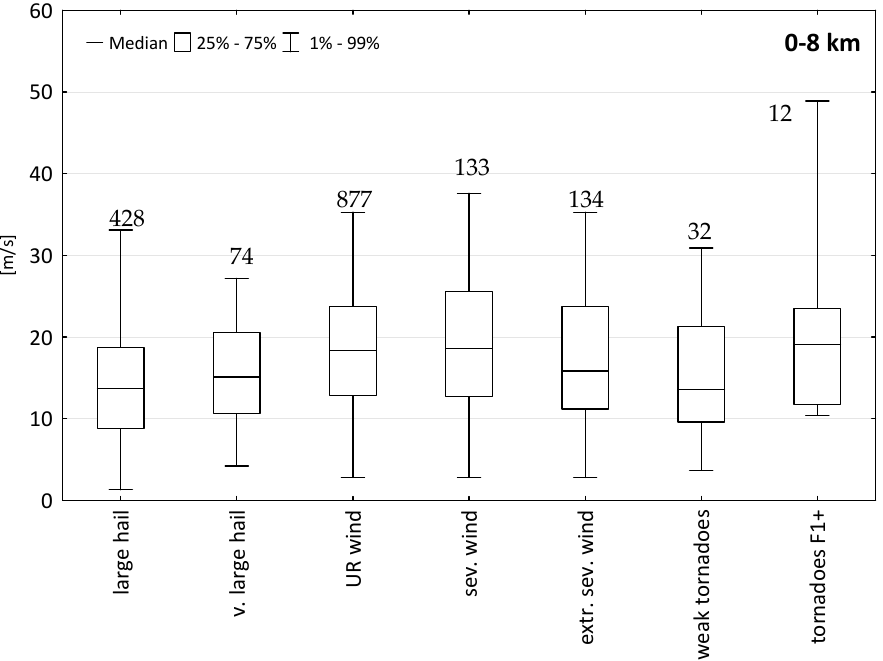
Figure 6. As in Figure 2, except for the 0–8 bulk wind shear.